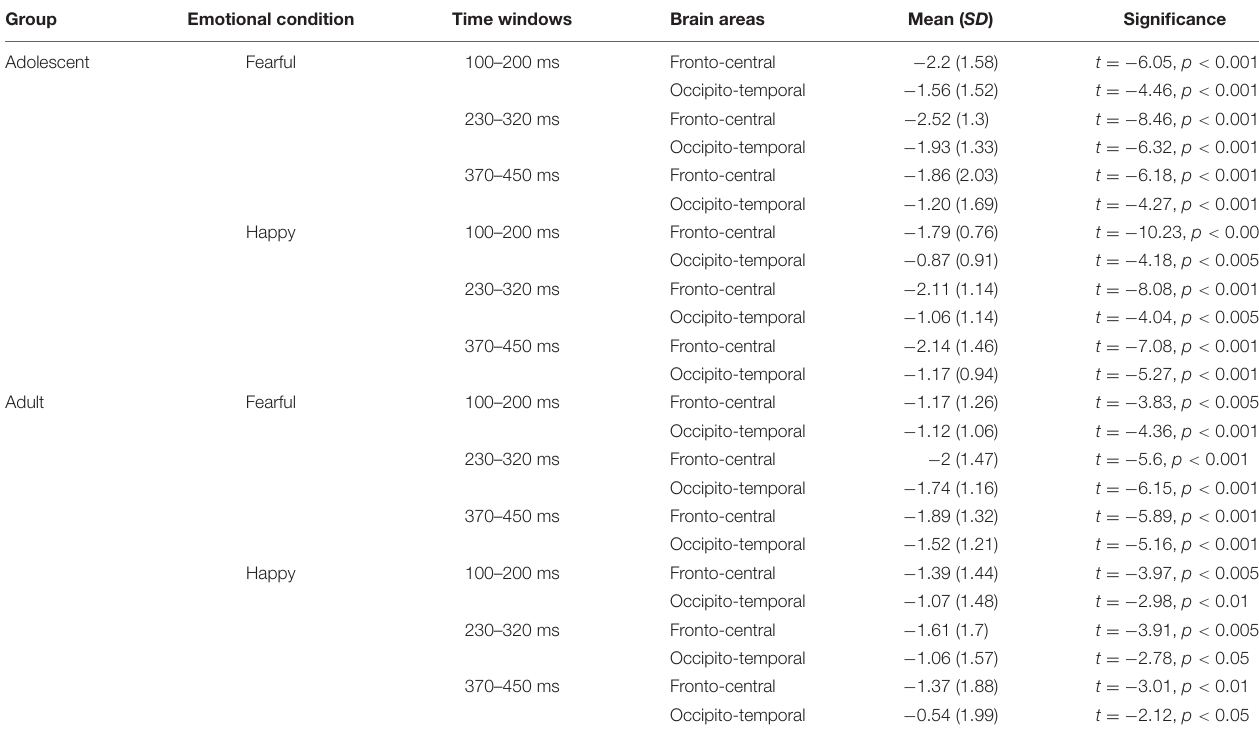
TABLE 1 | The comparisons between mean amplitudes ( µ V) of VMMN and zero in different brain areas, time windows, and emotional conditions. Group Emotional condition Time windows Brain